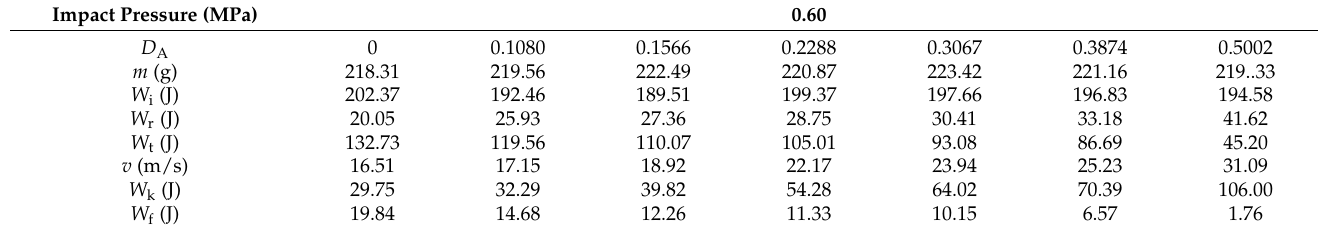
Table 4. Energy distribution of sandstone at an impact air pressure of 0.6 MPa.